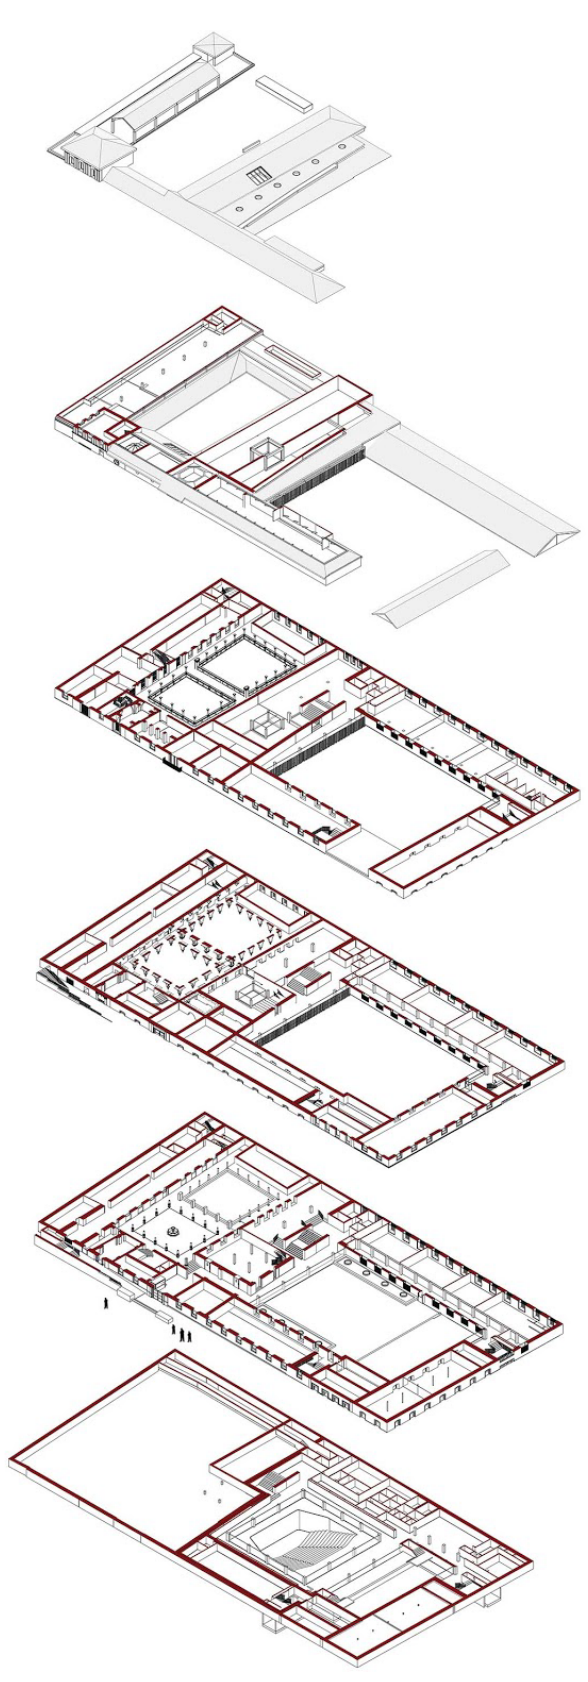
Figure 1. Axonometric cross-section of the building complex of the Escuela Técnica Superior de Arquitectura in Granada.